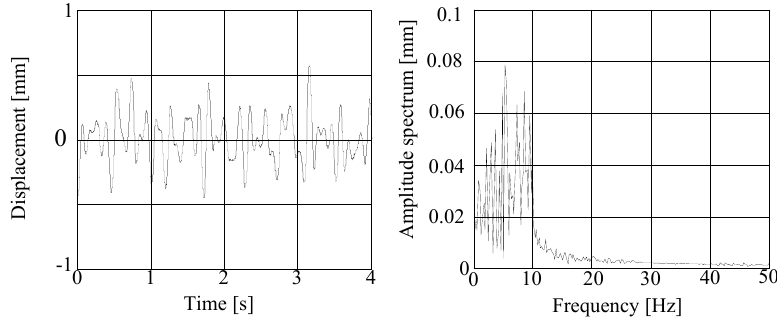
Figure 8. Time histories of displacement and amplitude spectrums of vibrating frames by random disturbance.